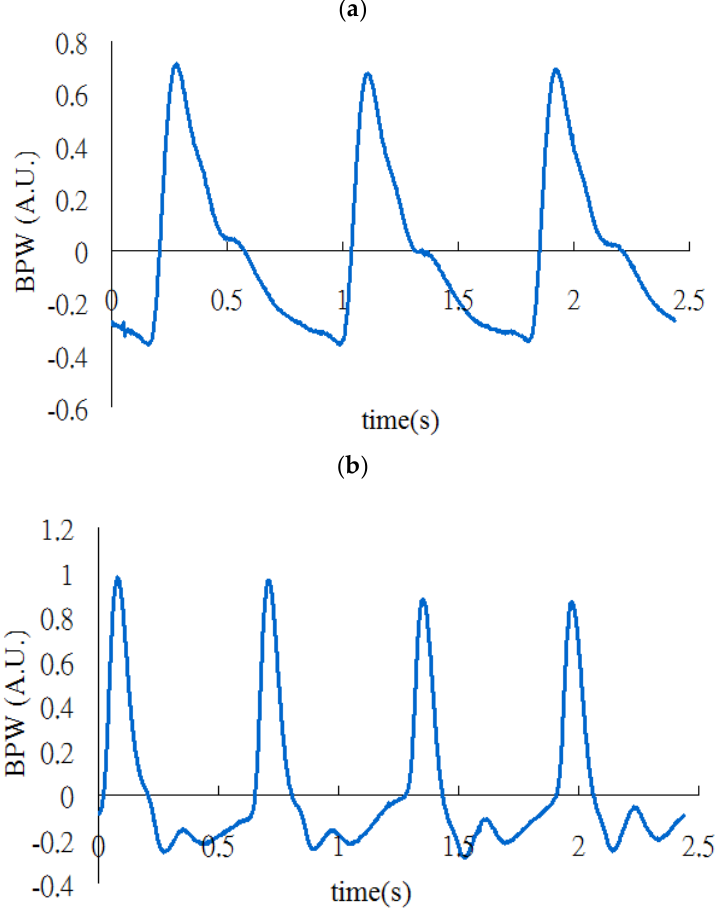
Figure 1. Typical measured pulse waveforms for ( a ) Data A (high quality) and ( b ) Data B (low quality).